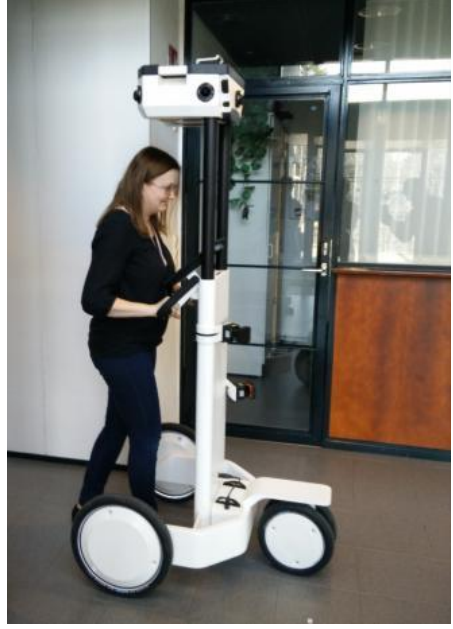
Figure 4. Data acquisition using